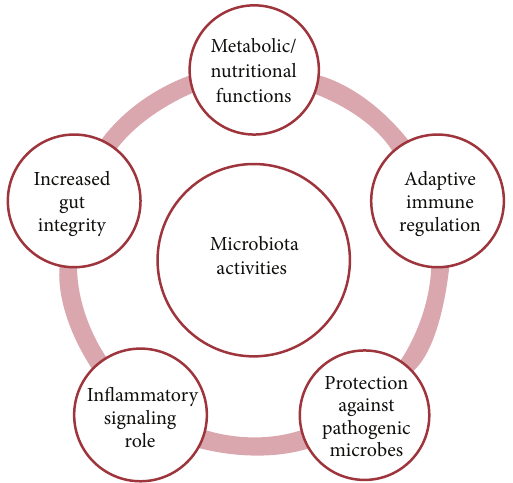
Figure 1: The different routes of interaction between the microbiota and the